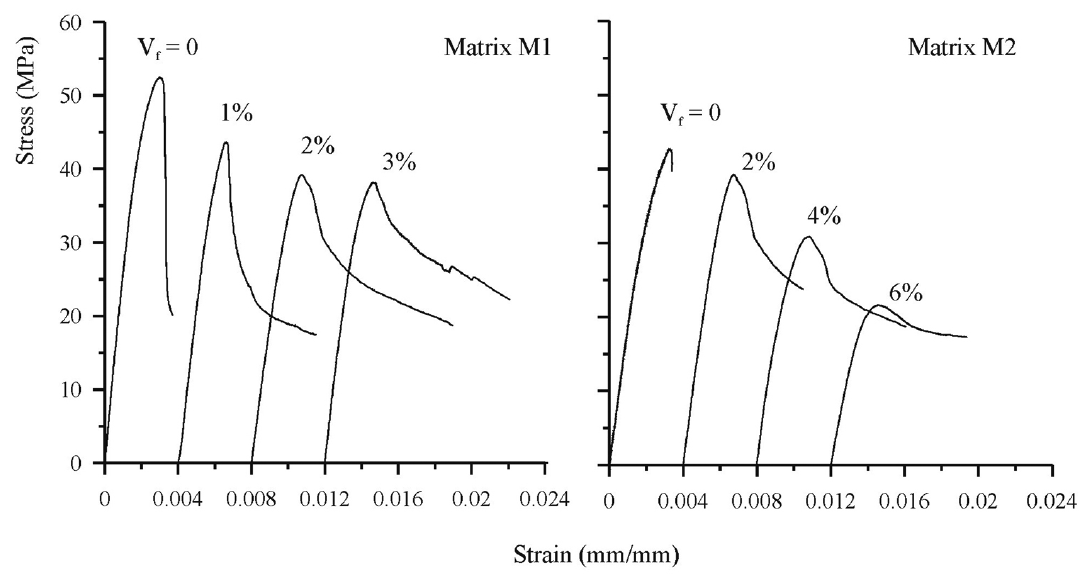
Figure 3. Typical stress-strain curves for the composites reinforced with 25 mm long sisal fibre.